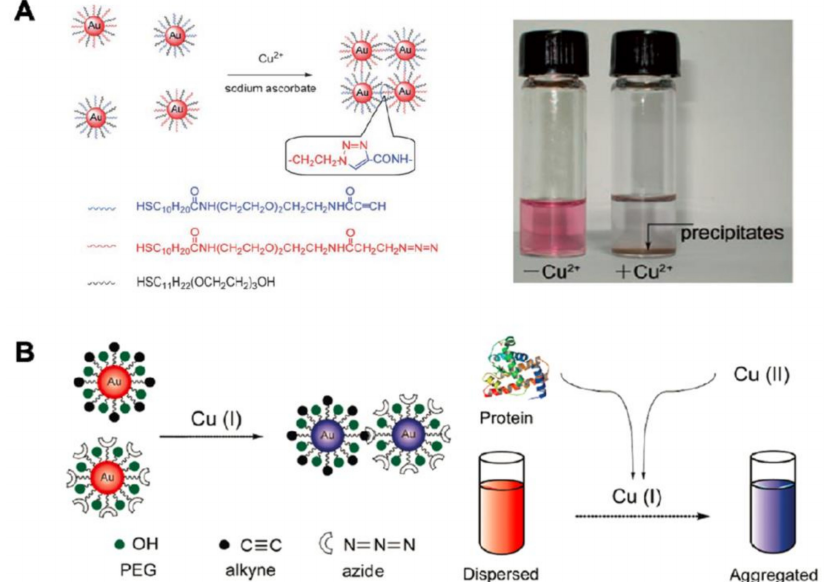
Figure 29. Cu(II) and protein visual identification of CuAAC arbitrated surface chemical Au NPs. In the presence of Cu(II), Au NPs are changed by ( A ) ligand- and alkyne-terminated, which can be taken into combination with CuAAC. Azide- and alkyne-terminated ligands. Ataken with authorisation from ref [213], Copyright 2008, Wiley. ( B ) Surface alteration of CuAAC-mediated au-NPs for the quantification of